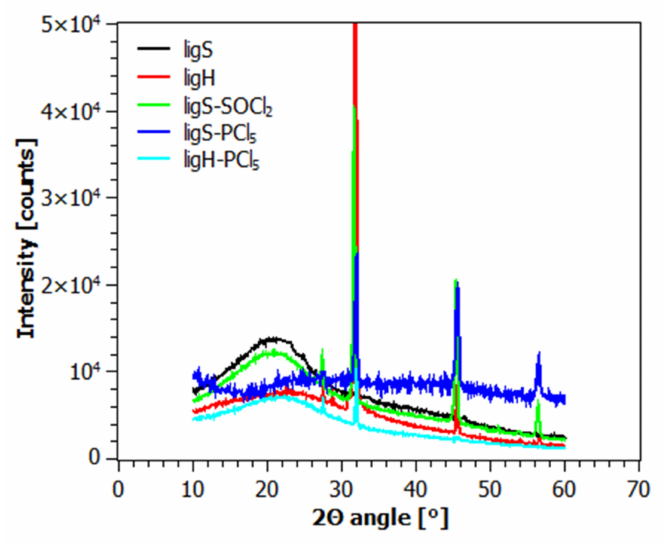
Figure 4. Diffraction patterns of the materials after the first step of modification.